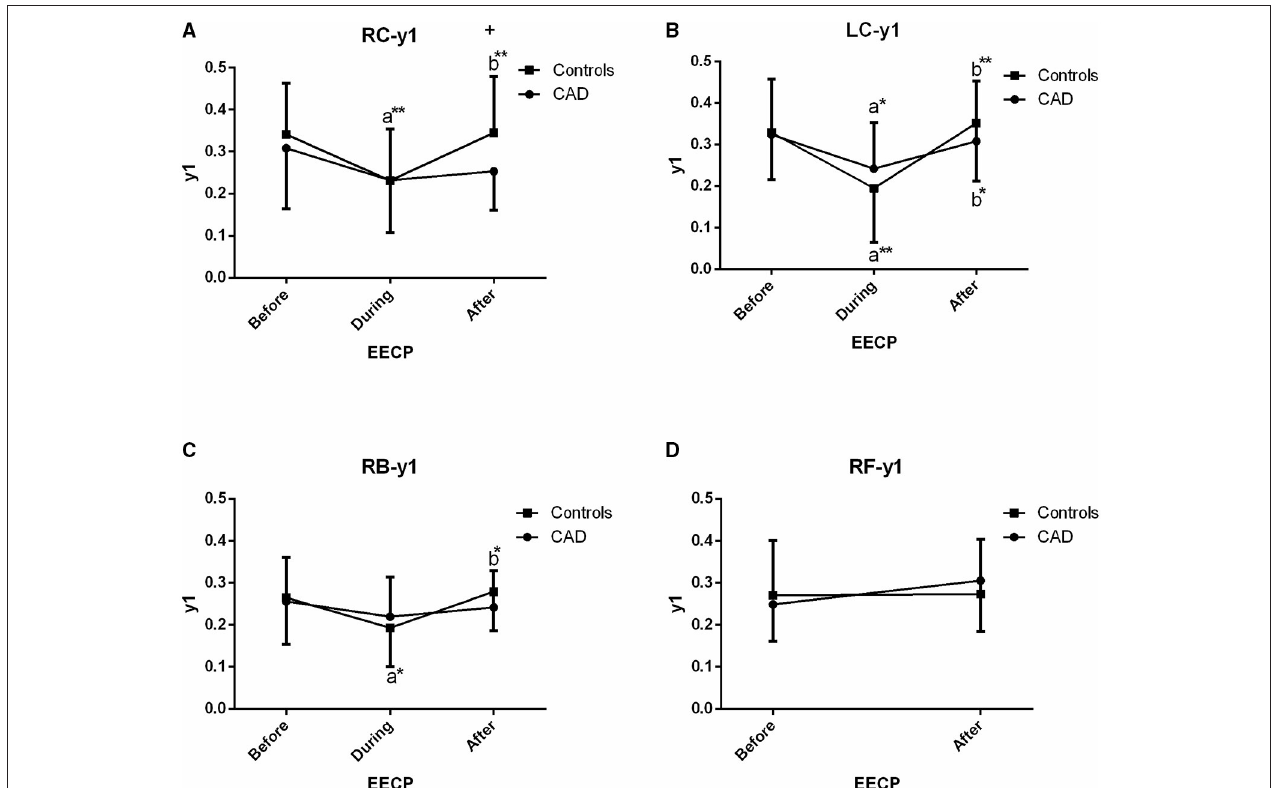
FIGURE 3 | Effect of EECP on the first peak amplitude (y1) of LC and right carotid (RC) arteries (A,B) , right brachial (RB) artery (C) and right femoral (RF) artery (D) in patients with CAD and controls before, during and after 45-min EECP. a indicates significant differences in measurements obtained during EECP vs. pre-EECP and b indicates differences between post-EECP vs. during-EECP. “*” and “**” denote values of p < 0.5 and < 0.01, respectively.